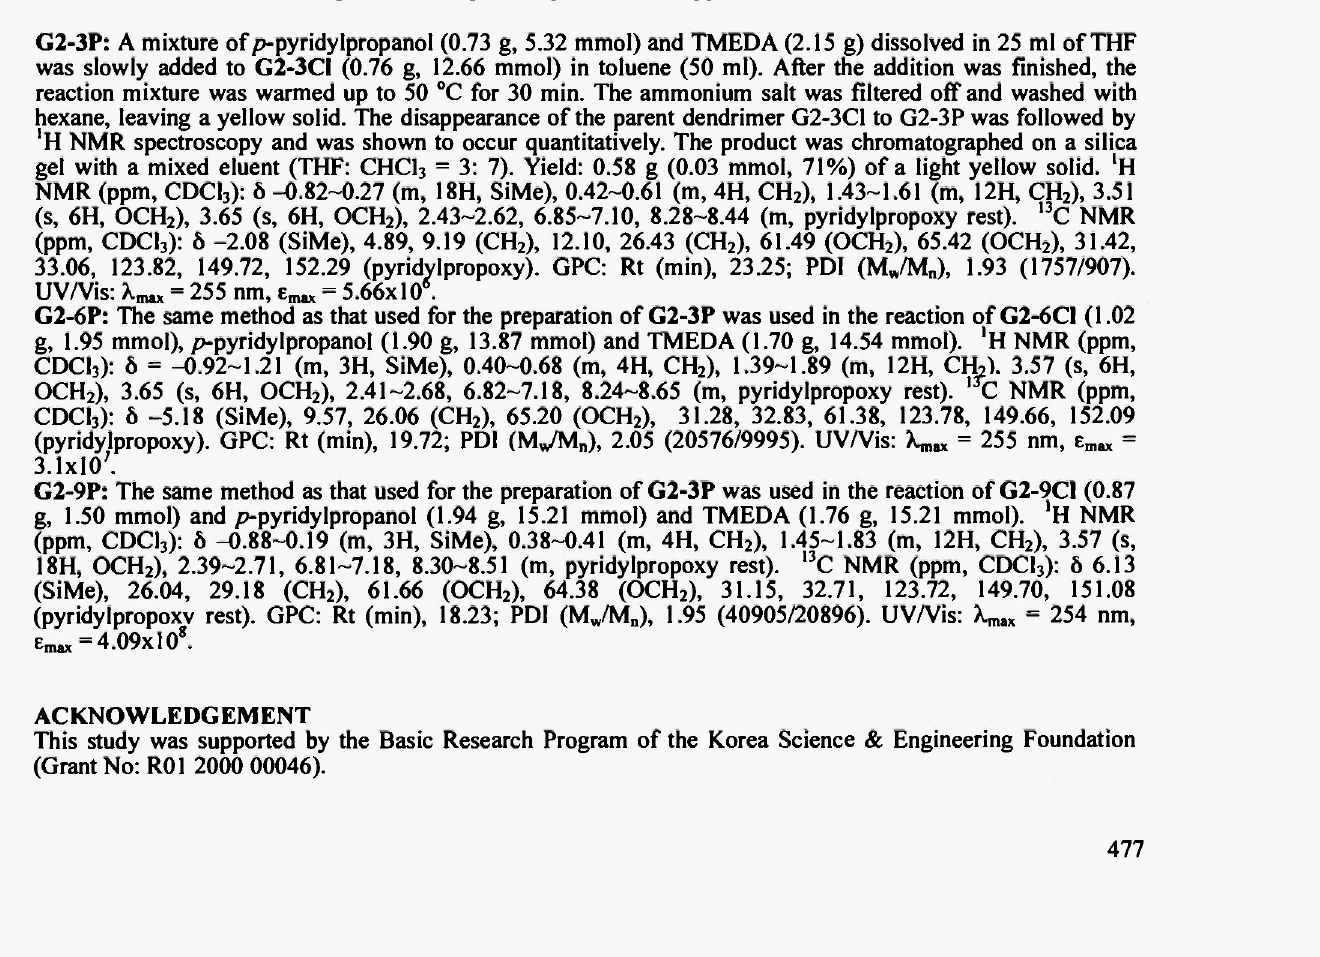
Fig. 2. GPC diagram of pyridyl end-capped